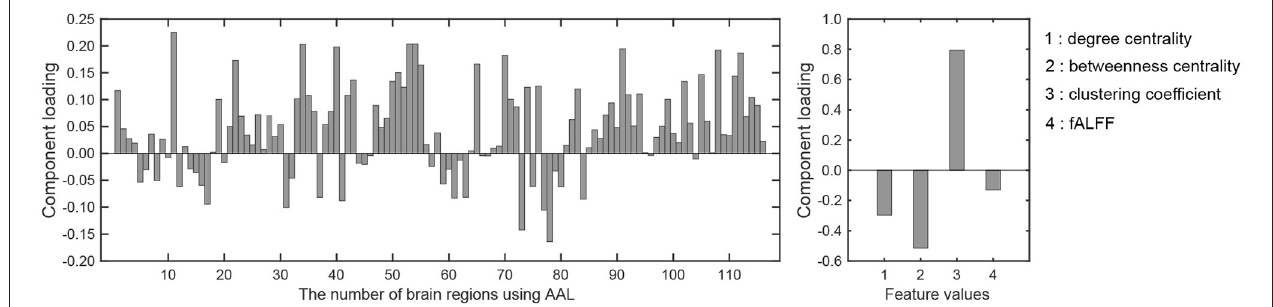
FIGURE 4 | Component loadings obtained by T3Clus. (Left) Loadings for brain regions. (Right) Loadings for four feature values.